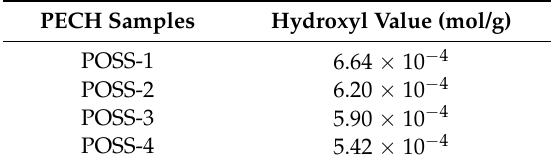
Table 4. Hydroxyl value of POSS–PECH with different molecular weights.